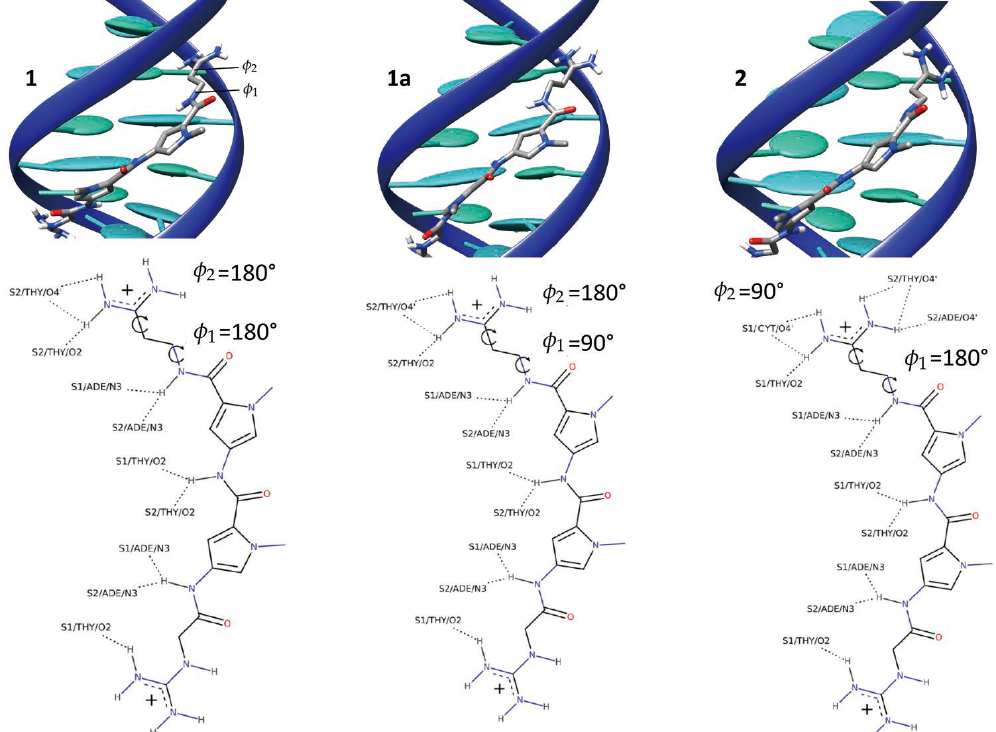
Figure 2. Representative snapshots illustrating the 1, 1a and 2 binding mode of netropsin with B-DNA. The main interactions developing in the three modes, as well as the characteristic values of the φ 1 and φ 2 dihedral are also